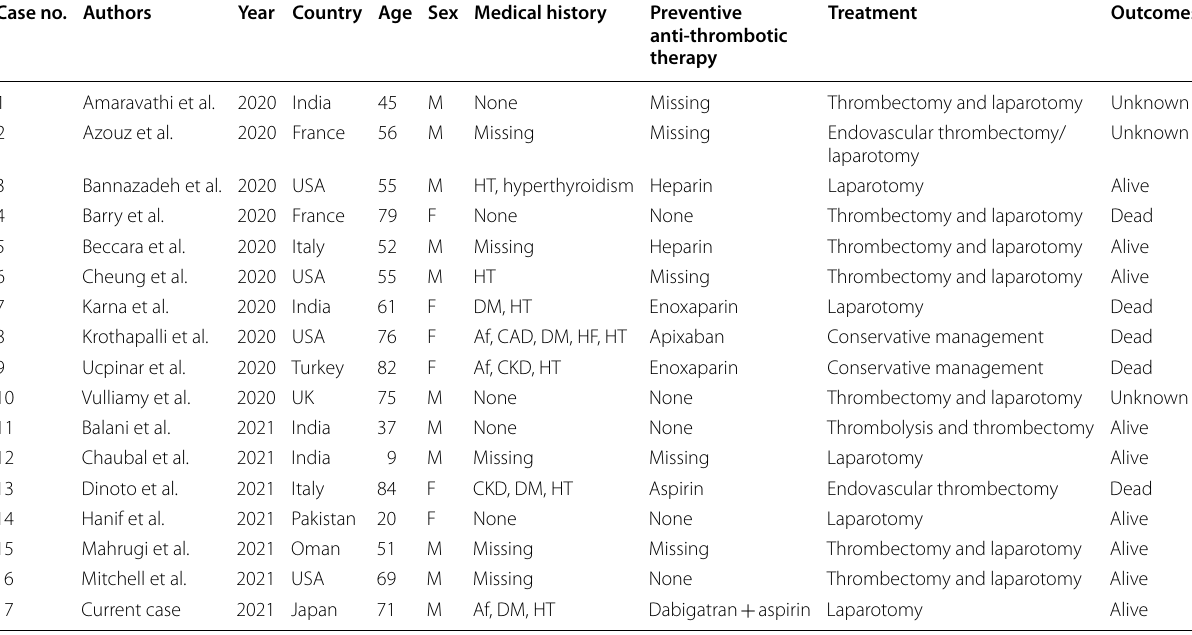
Table 1 Literature review: summary of the case reports of SMA thrombosis with COVID-19